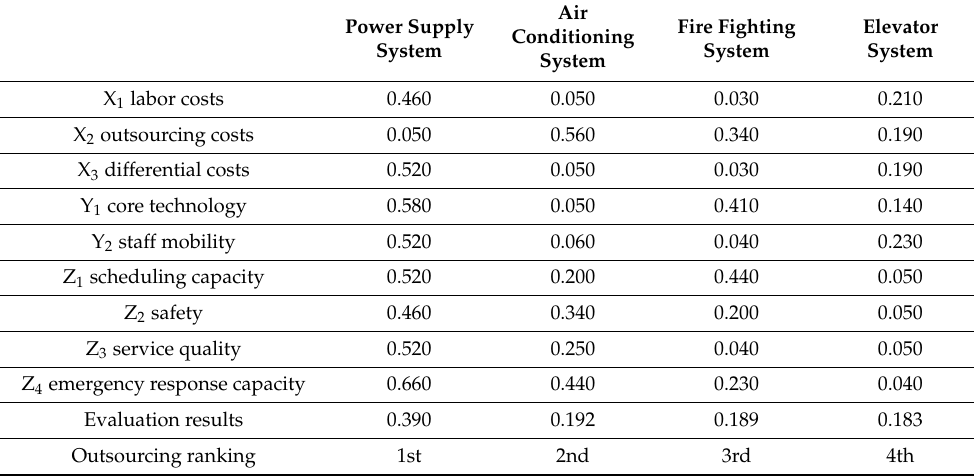
Table 5. Analysis of outsourcing priority of the electromechanical system’s four